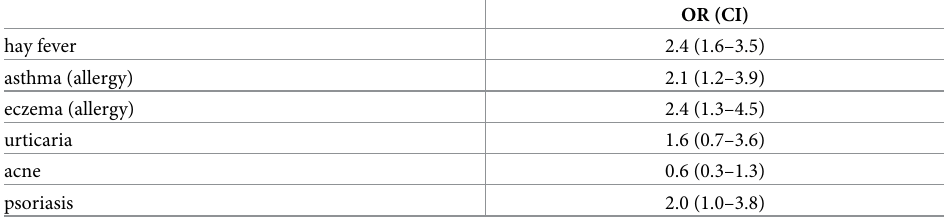
Table 7. PsyCoLaus: Associations between stuttering and skin / atopic diseases. Odds ratios and confidence inter- vals (95%), adjusted for sex.